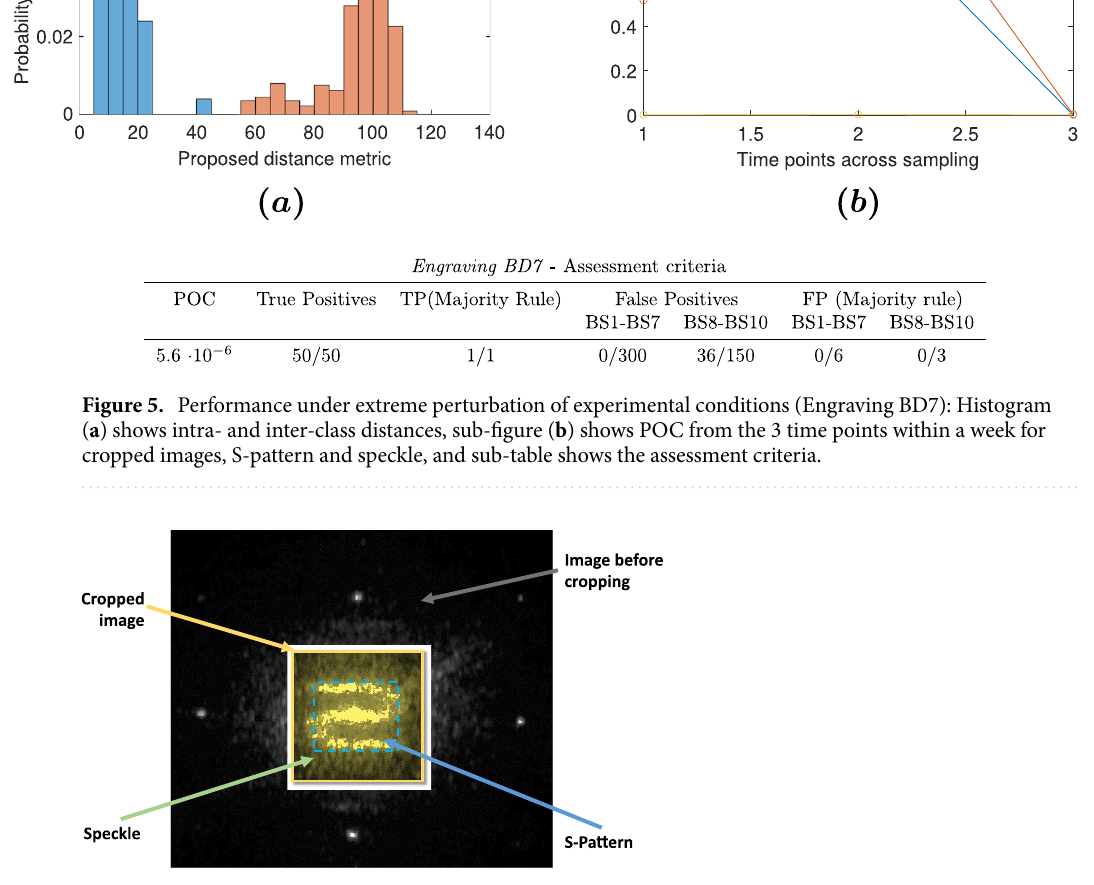
Figure 6. Example illustrating the image segmentation into the S-Pattern area and the pure speckle around